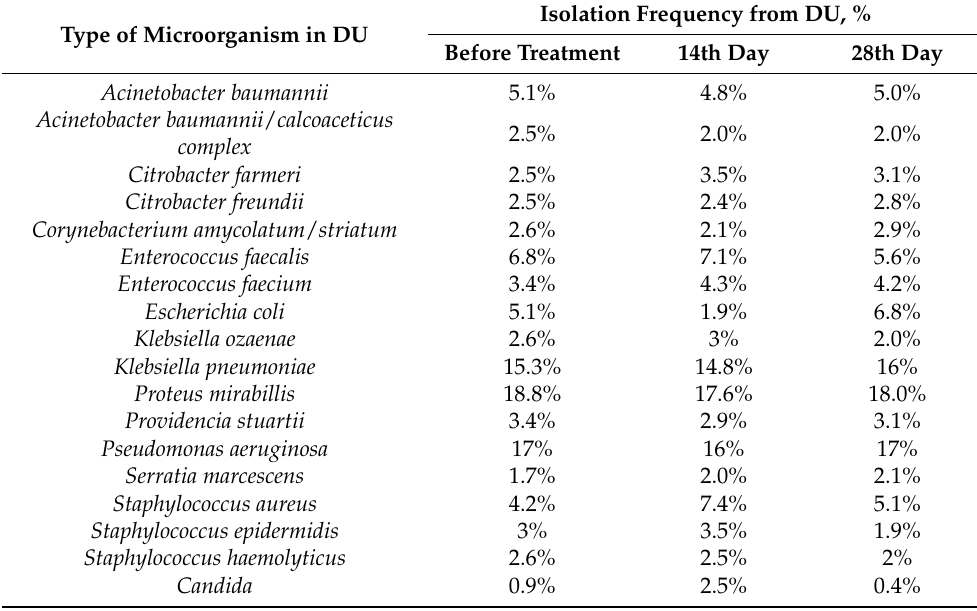
Table 3. Species composition of pathogenic bacteria in patients of the main